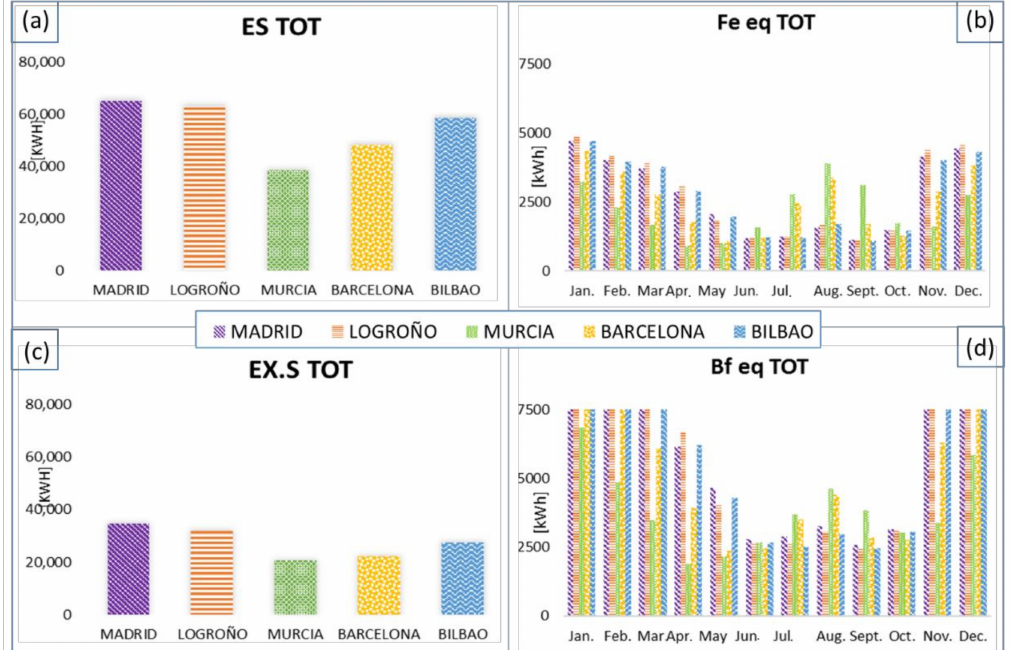
Figure 16. Yearly ( a , c ) total energy/exergy savings and ( b , d ) monthly total equivalent electric fuel/exergy consumption.